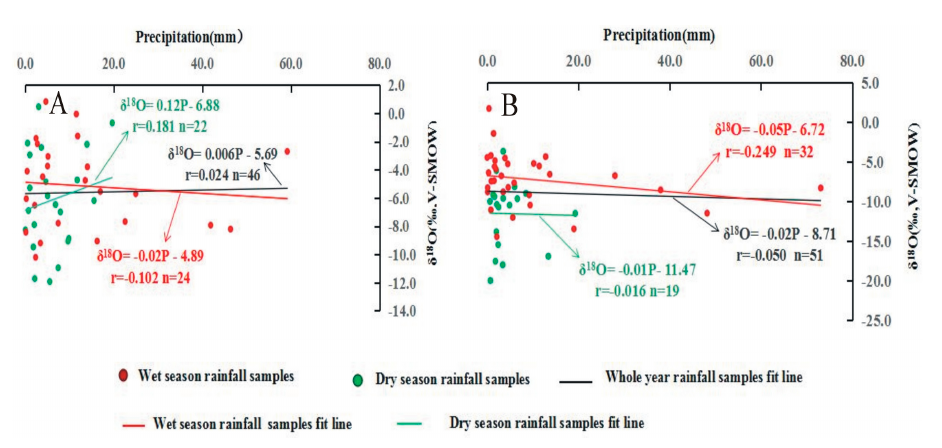
Figure 5. Relationship between δ 18 O precipitation and precipitation amount. ( A , B ) represent Fengxiang and Ningwu, respectively.